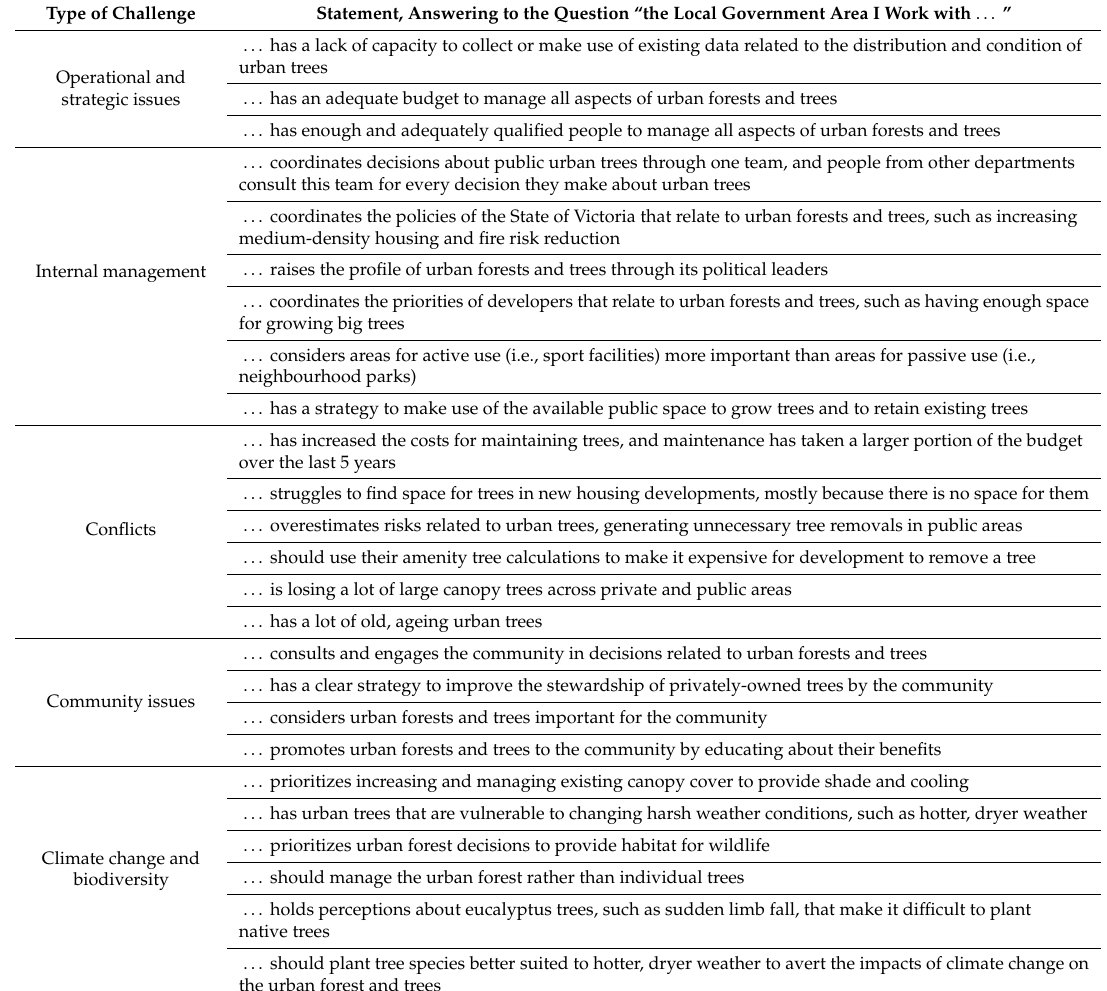
Table A1. Initial set of